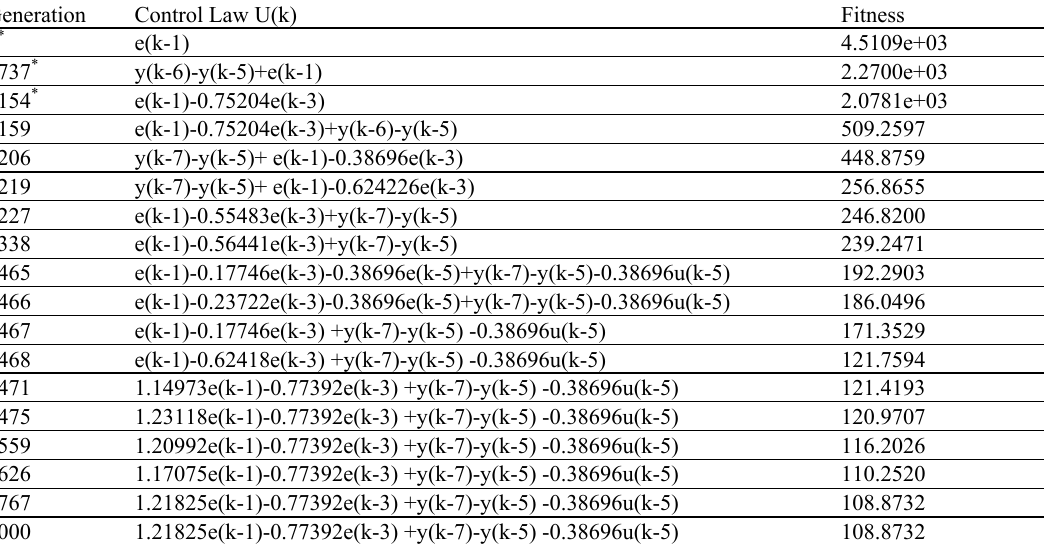
Table.1 Best controller evolution generation by